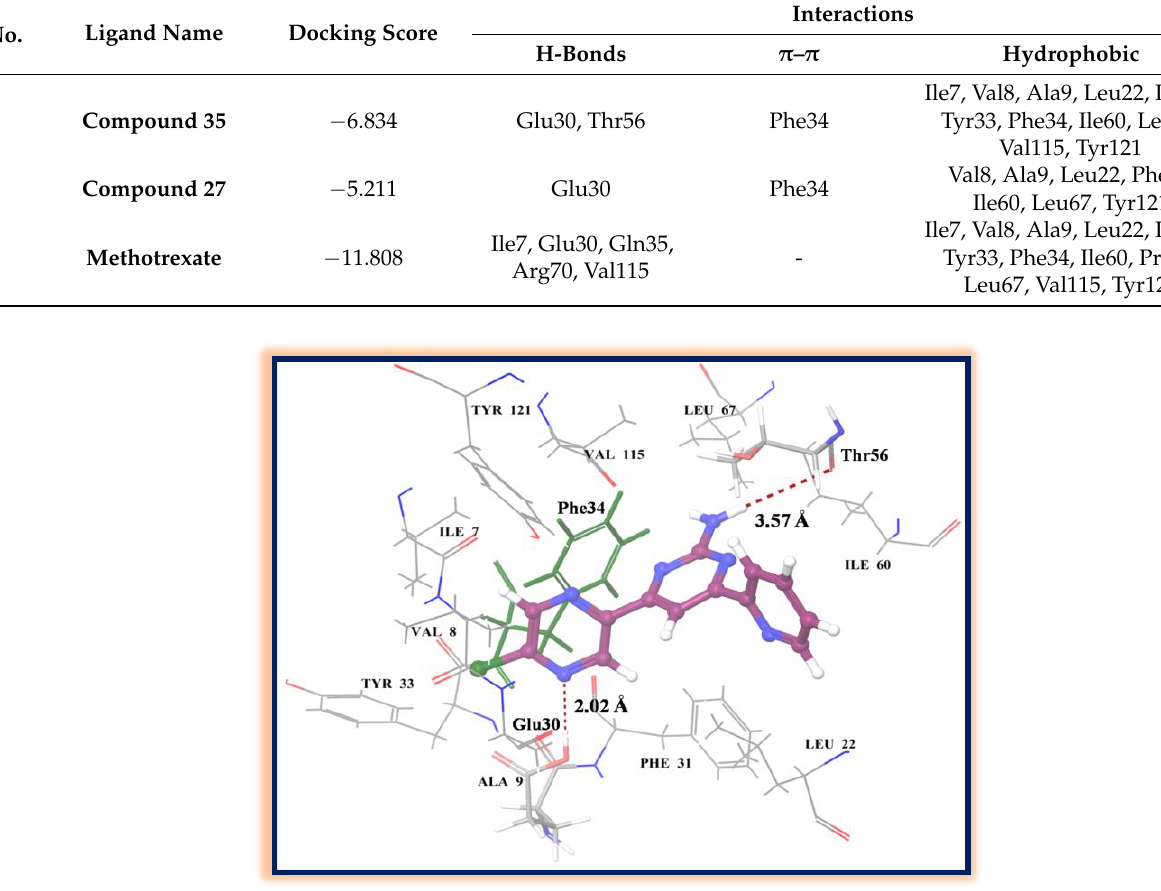
Figure 5. Docking model of compound 35 in the active site of the human dihydrofolate reductase receptor. The red dashed line represents a hydrogen bond. The dark green color residue (Phe34) is involved in the π–π interaction.